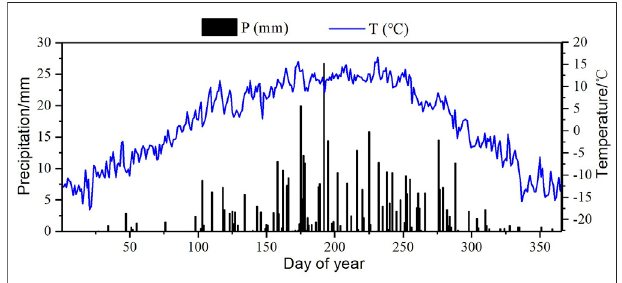
FIGURE 1 | Seasonal variation in precipitation and temperature in